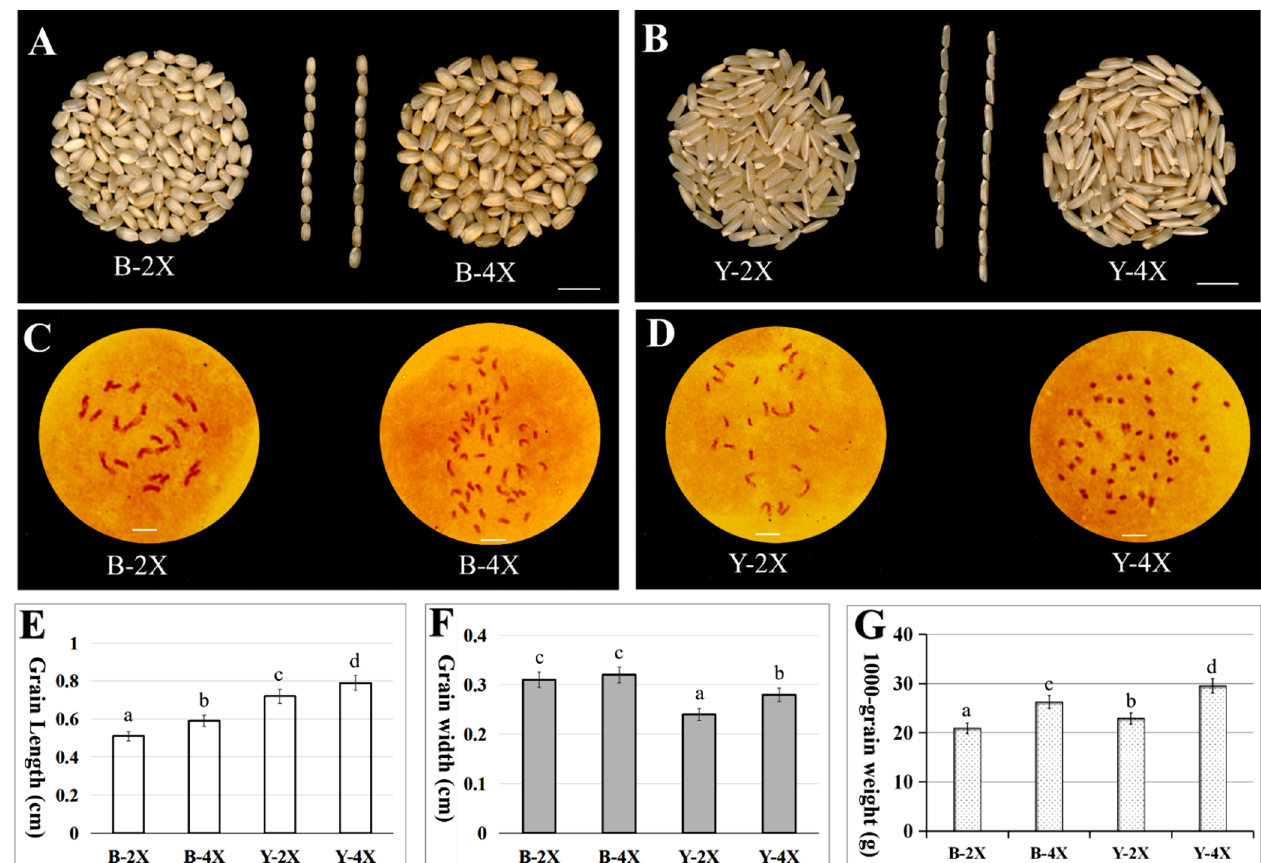
Figure 1. Brown rice comparison and chromosome identification between diploid and tetraploid rice. ( A ) Diploid brown rice of Balilla (B-2X) vs. tetraploid brown rice of Balilla (B-4X). In the middle, 10 B-2X (left) are compared with 10 B-4X (right) with respect to length. ( B ) Diploid brown rice of Yangdao 6 (Y-2X) vs. tetraploid brown rice of Yangdao 6 (Y-4X). In the middle, 10 Y-2X (left) are compared with 10 Y-4X (right) with respect to length. ( C , D ) Root tip chromosomes of rice. ( C ) B-2X: diploid Balilla (2n = 2 x = 24); B-4X: tetraploid Balilla (2n = 4 x = 48). ( D ) Y-2X: diploid Yangdao 6 (2n = 2 x = 24); Y-4X: tetraploid Yangdao 6 (2n = 4 x = 48). ( E – G ) Comparison between diploid and tetraploid brown rice: ( E ) grain length, ( F ) grain width and ( G ) 1000-grain weight. Duncan’s multi- ple range test method was used for analysis. Different letters in the same column indicate significant differences ( p < 0.05). Bars = 1 cm in ( A , B ), 5 µm in ( C , D ).